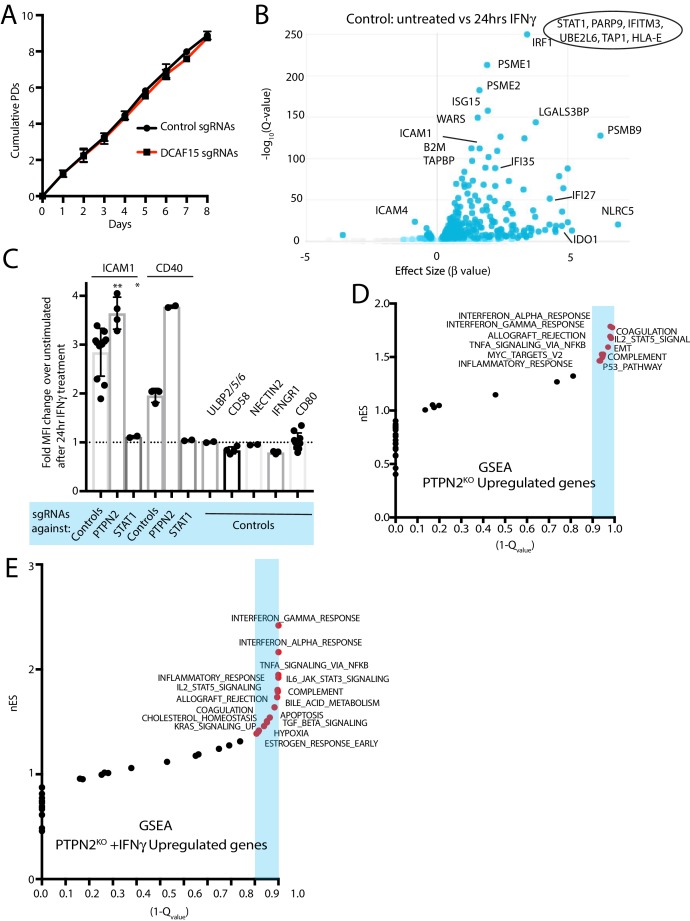
Transcriptional responses of K562 DCAF15 KO and PTPN2 KO cells to IFNγ.(A) Growth rate of K562 cells expressing sgRNAs against DCAF15 or a control gene. Results from 2 to 3 independent experiments and 2–3 different sgRNAs per gene. Mean and standard deviation are shown. DCAF15 sgRNAs, 1.1+ /- 0.01 population doublings per day. Control sgRNAs, 1.13+ /- 0.03 population doublings per day. (B) Volcano plot of genes differentially expressed in control K562 cells after 24 hr of IFNγ treatment. Selected genes are highlighted. Genes that were off-scale and could not be plotted are shown in the oval. The FDR-corrected P-value generated from a likelihood ratio test (Q-value) is plotted against an approximate measure of the fold change in expression (Beta value). (C) Flow cytometry analysis of the change in cell surface expression of the indicated cell surface markers in K562 cells transduced with the indicated sgRNAs after 24 hr of 10 ng/ml IFNγ treatment. **p value=0.003, *p value=0.026, Mann-Whitney test. (D) Gene set enrichment analysis (GSEA) of genes differentially upregulated in PTPN2 KO cells. nES, normalized enrichment score. Categories with a FDR Q-value of <0.1 are shaded in blue. E)GSEA of genes differentially upregulated in PTPN2 KO cells after IFNγ treatment.